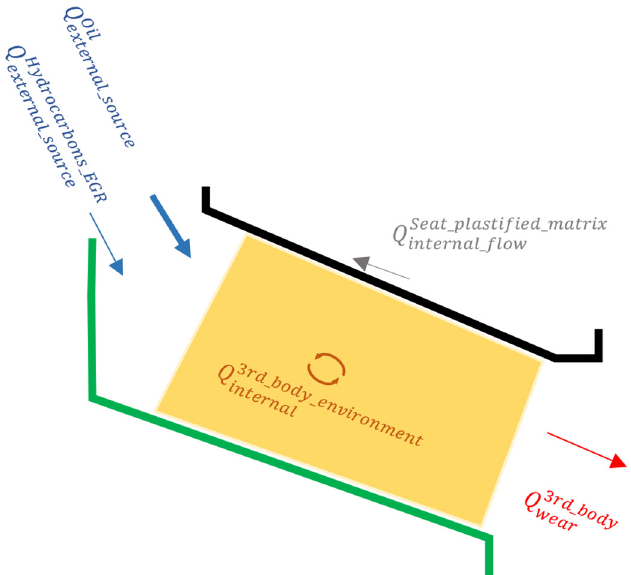
Fig. 30. Tribological circuit with external source fl ow and for a temperature of 250 °